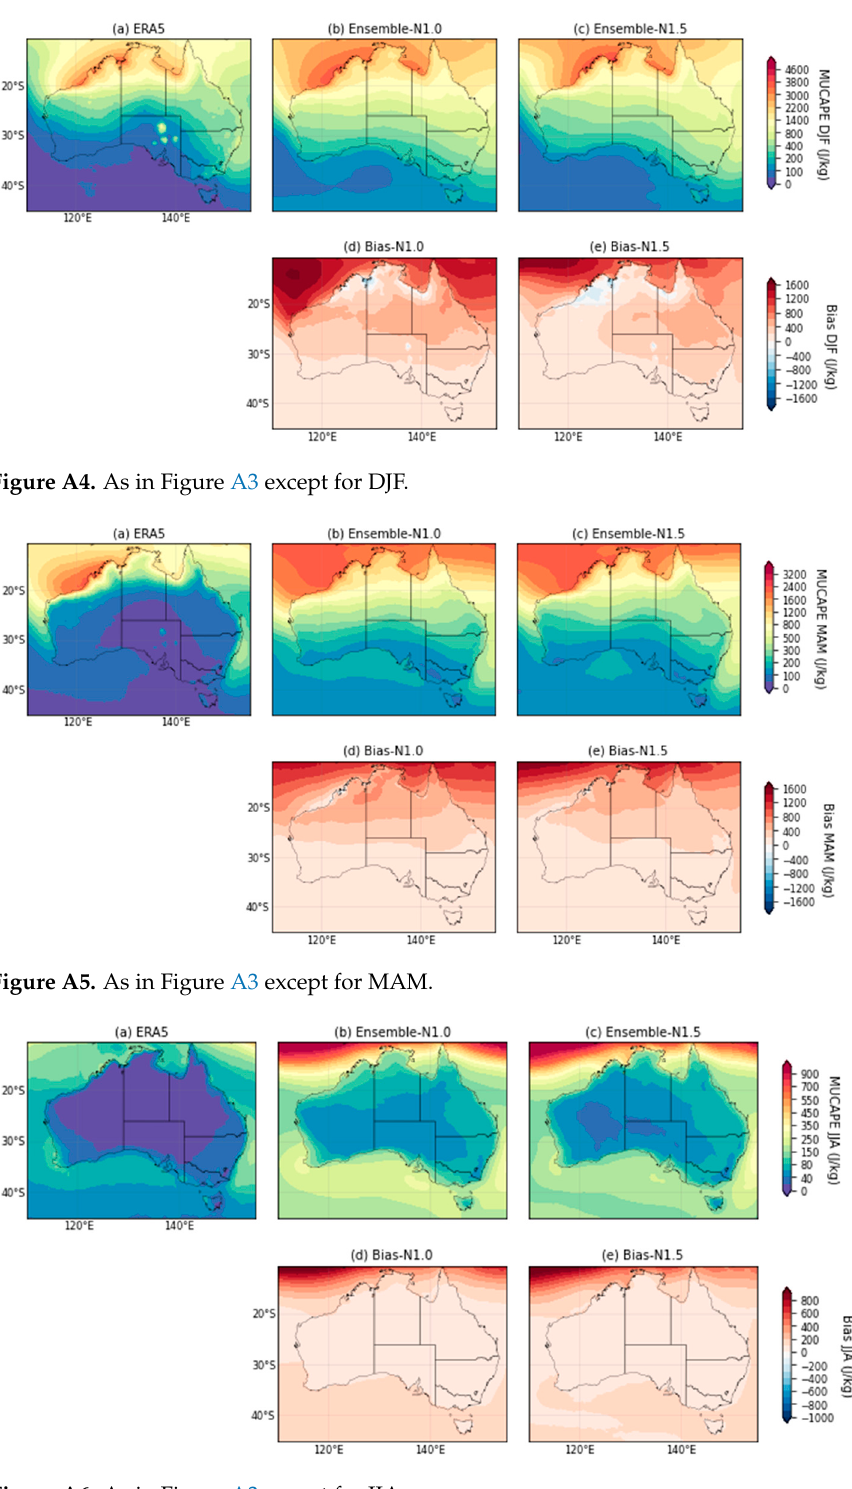
Figure A6. As in Figure A3 except for JJA.